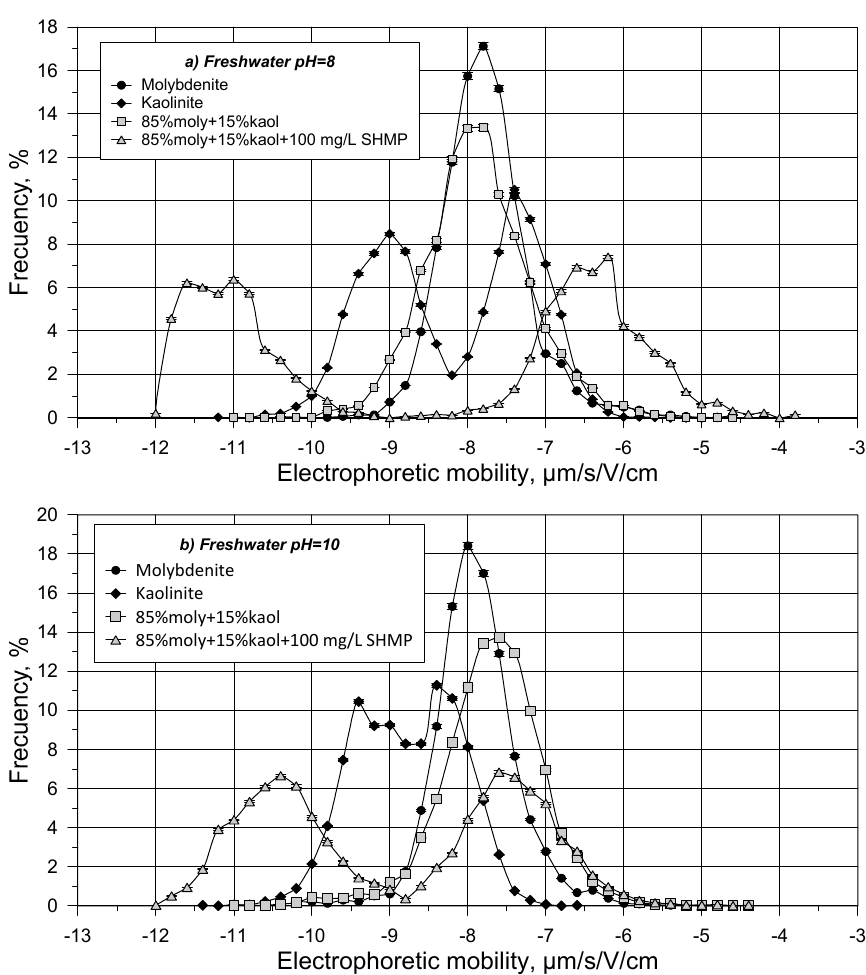
Figure 7. Electrophoretic mobility distributions of particles of molybdenite, kaolinite, and 85% molybdenite + 15% kaolinite with and without SHMP in freshwater at pH 8 ( a ) and 10 ( b ). Moly: molybdenite; kaol: kaolinite.